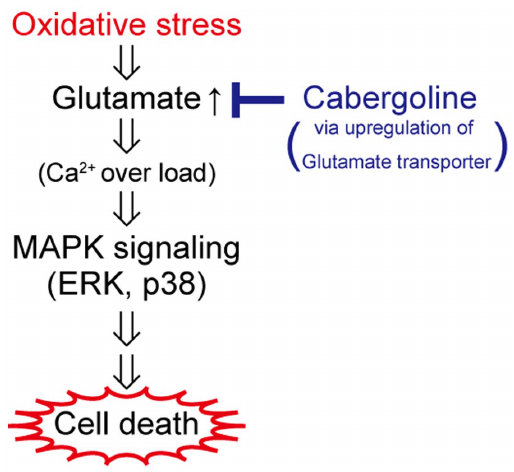
Figure 8. Schematic representation of neuroprotection of cortical neurons by cabergoline. Oxidative stress (H 2 O 2 ) causes extracellular glutamate accumulation and subsequent Ca 2 + over-load in cultured cortical neurons. Then, activated MAPK cascades (ERK and/or p38) are triggered to induce neuronal cell death. Cabergoline treatment decreases extracellular levels of glutamate stimulated by oxidative stress, presumably via upregulation of glutamate transporter (EAAC1/ GLT1)